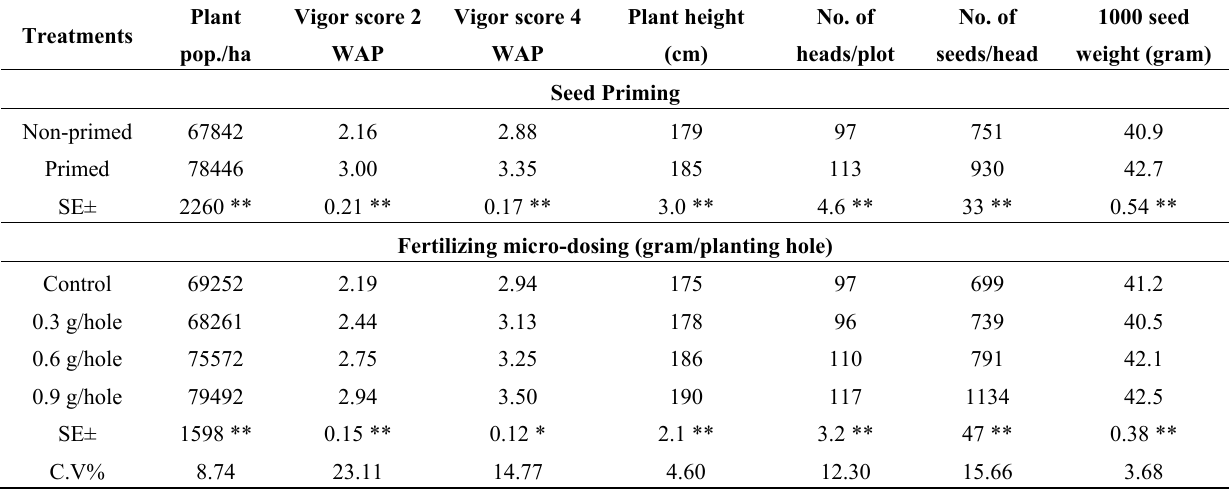
Table 2. Effect of seed priming and fertilizer micro-dosing on some traits of sorghum (combined across two